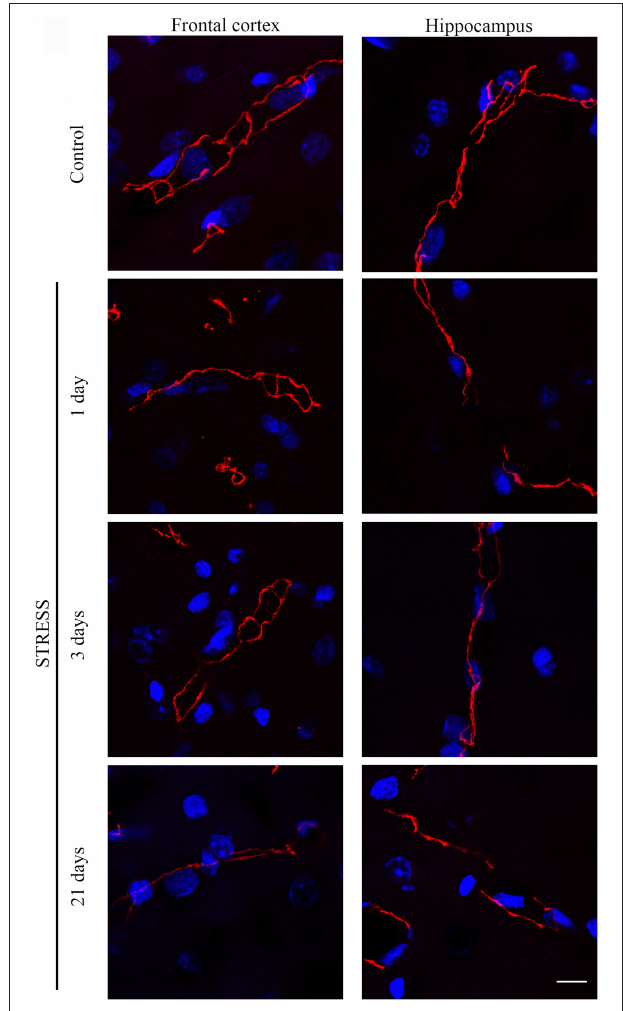
FIGURE 4 | Expression of occludin in rat frontal cortex and hippocampus of control and stressed rats. Sagittal brain sections of control and stressed rats were immunostained for tight junction protein occludin of brain capillaries. Red color: immunostaining for occludin. Blue color: cell nuclei stained with Hoechst dye 33342. Scale bar: 15 µ